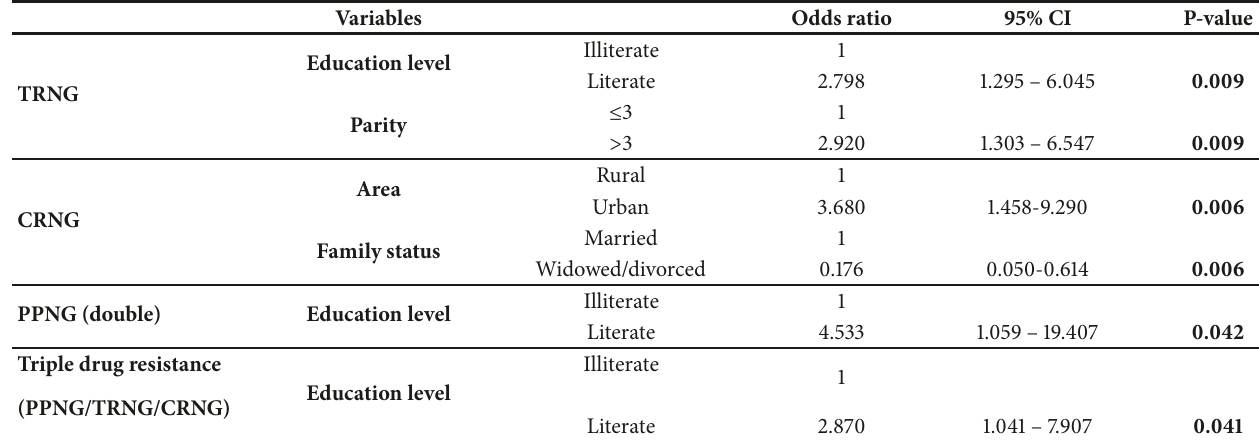
Table 8: Variables associated with NG resistance types (multivariate